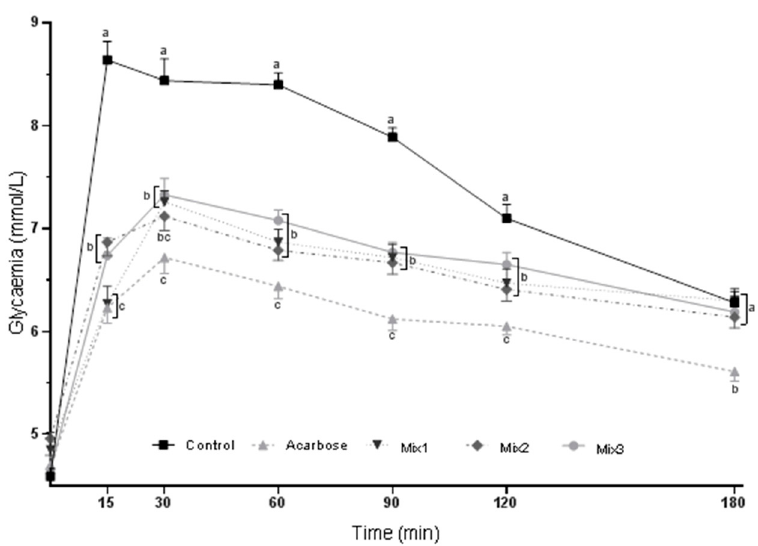
Figure 1 . Blood glucose curves for the oral sucrose tolerance test (SuTT) in rats gavaged with acarbose or the composed mixtures. Values are expressed as the mean ± SEM ( n = 12). Mean values with differing letters within a time period (a, b, c) are significantly different at p < 0.05 in a post hoc test. BW, body weight. Composition and doses (mg/kg BW): Mix1—mulberry leaf extract (120 mg) + kidney bean extract (100 mg) + coffee bean extract (20 mg); Mix2—mulberry leaf extract (120 mg) + coffee bean extract (20 mg) + arabinose (25 mg); Mix3—mulberry leaf extract (120 mg) + kidney bean extract (100 mg) + coffee bean extract (20 mg) + arabinose (25 mg).